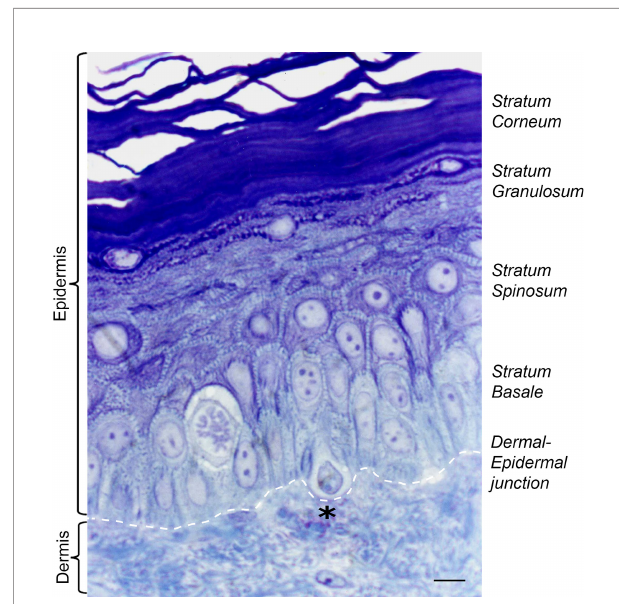
FIGURE 1 | Histology of adult human skin. The epidermal layers of the skin are composed mostly of keratinocytes (90%) and melanocytes (3%). Melanocytes sit at the dermal epidermal junction, surrounded by proliferating keratinocytes of stratum basale , which differentiate as they reach the upper layers of epidermis. Black asterisk denotes a pendulous melanocyte localized at the basal layer of the human epidermis. Staining Toluidine blue (1%) in Borax solution (1%). Scale bar 5 m